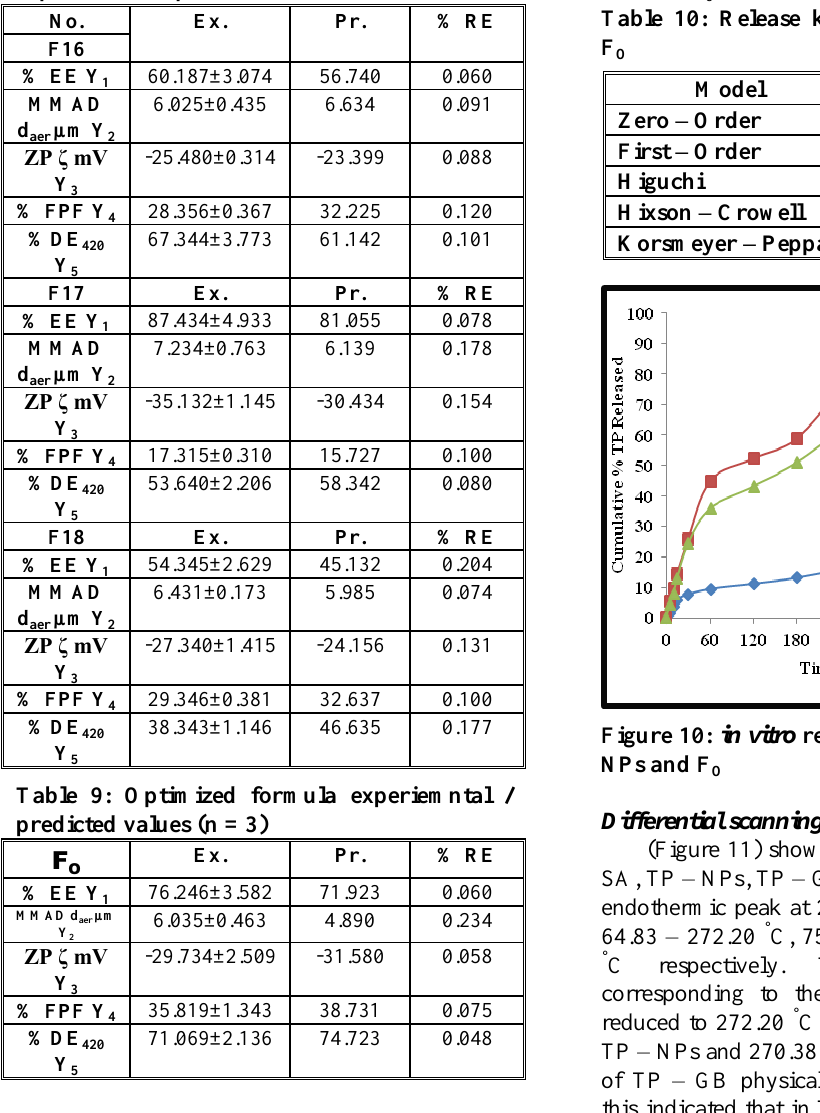
Table 8: Checkpoint formulations comparing